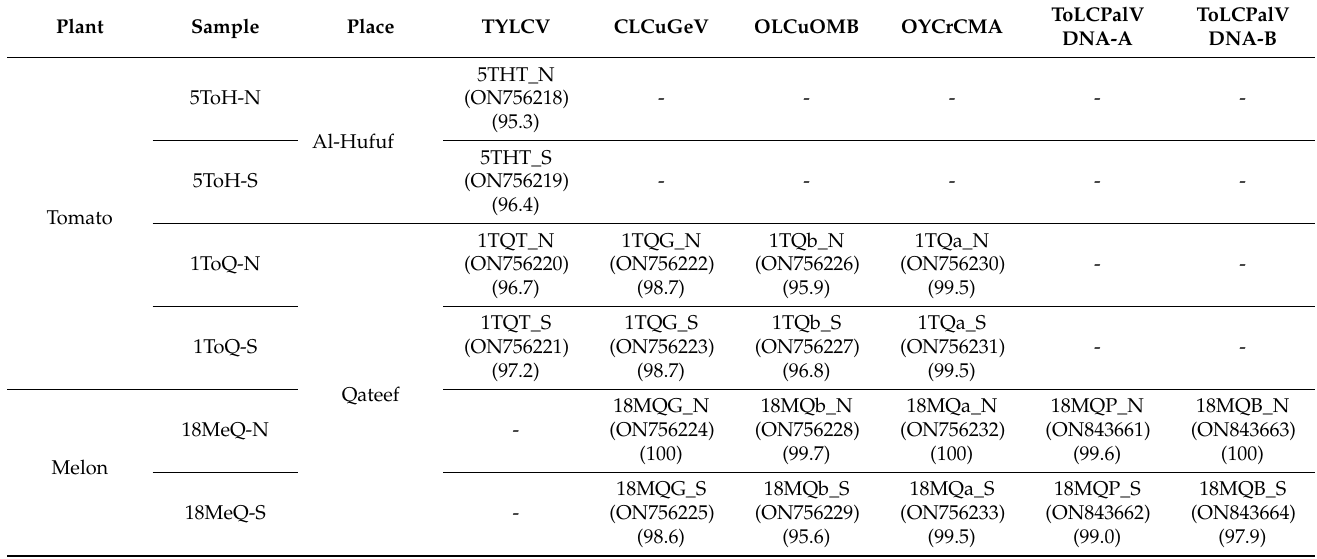
Table 1. Sample collection and complete genome sequencing using Illumina MiSeq and Sanger sequencing